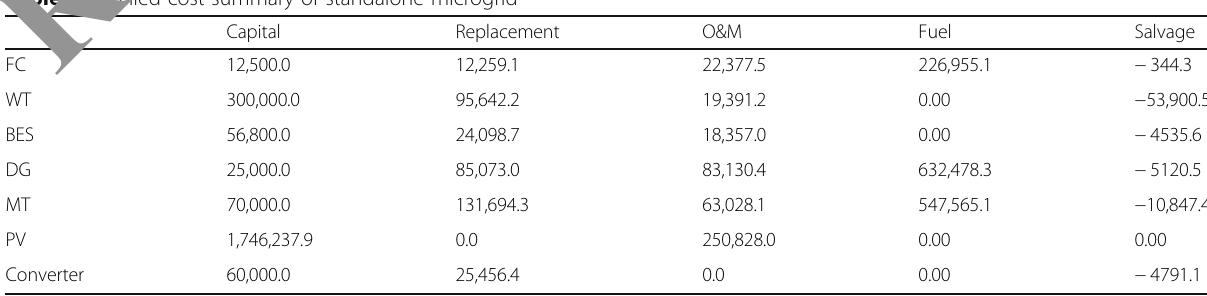
Fig. 15 Cost summary of standalone microgrid